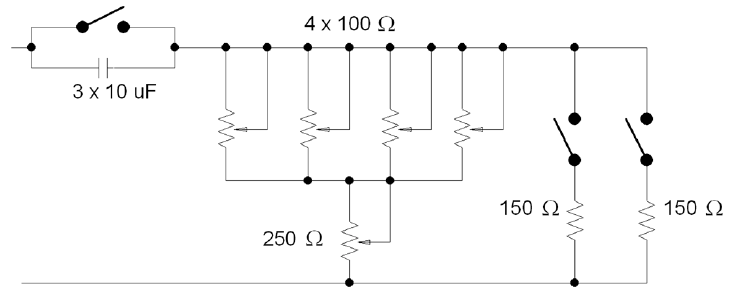
Figure 9. Variable load designed to test the TMR wattmeter.